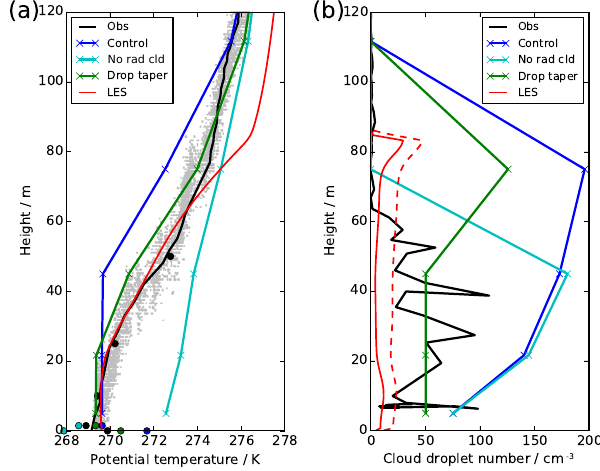
Figure 10. Profiles at 03:30UTC showing observations, LES (red) and UKV experiments: control (blue), radiatively inactive cloud (cyan) and modified droplet number (green), showing (a) poten- tial temperature and (b) cloud droplet number concentration. Model profiles show model-level data (crosses) and diagnosed screen and surface-level temperature (filled circles). For the LES droplet num- ber, we show only the activated droplets (solid) and all particles > 2µm